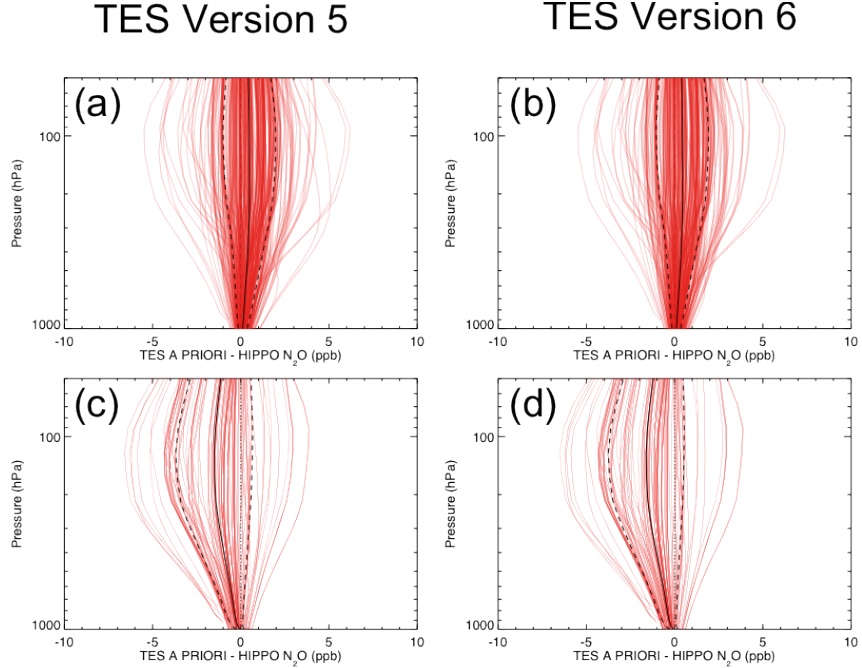
Figure 13. Differences between the TES N 2 O a priori profiles and the measured HIPPO N 2 O profiles. The red lines are for each TES spectra analyzed, while the black solid line shows the mean differences and the black dashed lines show the standard deviation. (a) TES Version 5 N 2 O a priori for TES CH 4 retrievals with DOFS ≥ 1.6 (generally between 50 ◦ S and 50 ◦ N). (b) TES Version 6 N 2 O a priori for TES CH 4 retrievals with DOFS ≥ 1.6. (c) TES Version 5 N 2 O a priori for TES CH 4 retrievals with DOFS < 1.6 (generally between 30 ◦ N and 70 ◦ N). (d) TES Version 6 N 2 O a priori for TES CH 4 retrievals with DOFS <